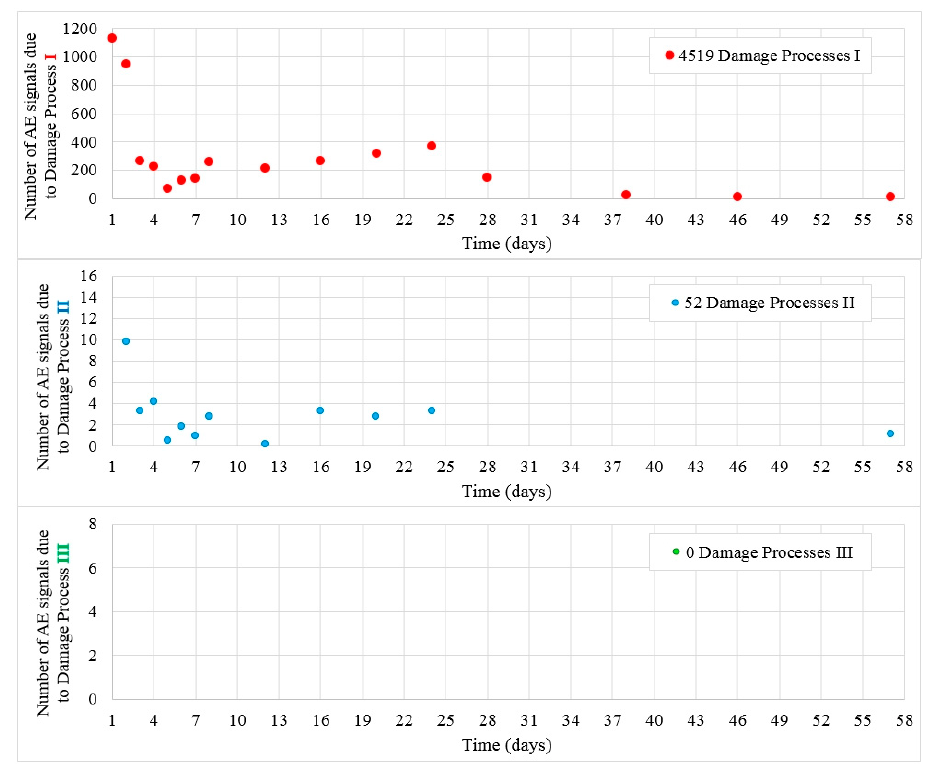
Figure 12. Number of damage processes I–III obtained from B2 samples.